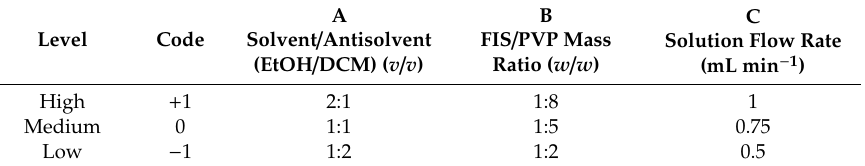
Table 2. Experimental factors and levels of the Minitab analysis design. DCM: dichloromethane.